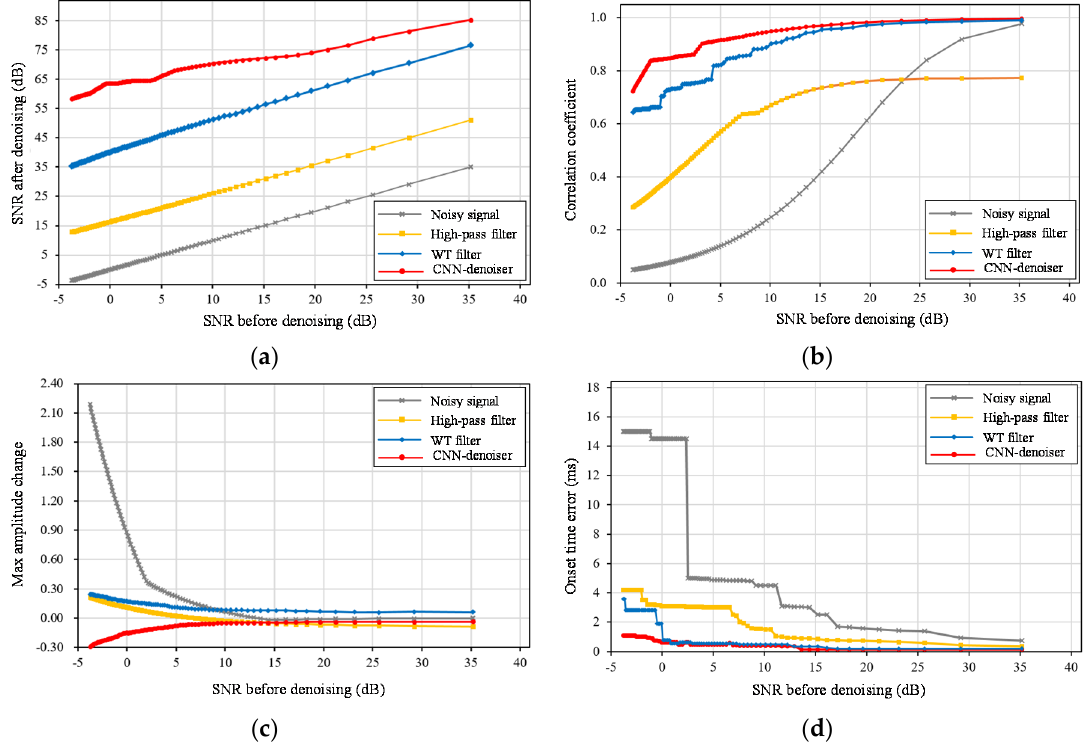
Figure 9. Performance comparison between high-pass filter, wavelet threshold (WT) filter and CNN-denoiser. ( a – c ) Improvement of SNRs, correlation coefficient, and max amplitude changes between the high-pass filter, WT filter and CNN-denoiser. ( d ) The error of onset time picking by Short Term Averaging / Long Term Averaging (STA / LTA) (applied to noisy signal and that denoised by a high-pass filter, WT filter and CNN-denoiser). Values in ( b ) are calculated by Pearson product-moment correlation coefficient [30] between the estimated signals (noisy signal and that denoised by a high-pass filter, WT filter and CNN-denoiser) and the clean signal in Figure 8. Values in ( c ) and ( d ) are differences between the estimated signals (noisy signal and that denoised by a high-pass filter, WT filter and CNN-denoiser) and the clean signal in Figure 8.